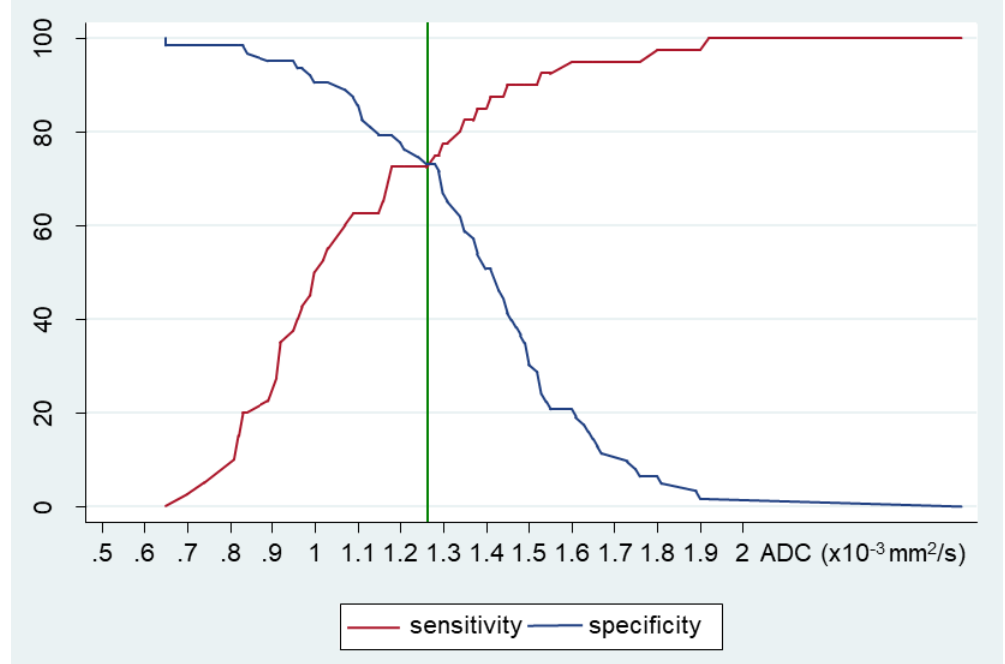
Figure 3. Results of the ROC-based positive test at different ADC values. The optimum cut-off level is determined to be 1.265×10 -3 mm 2 /s